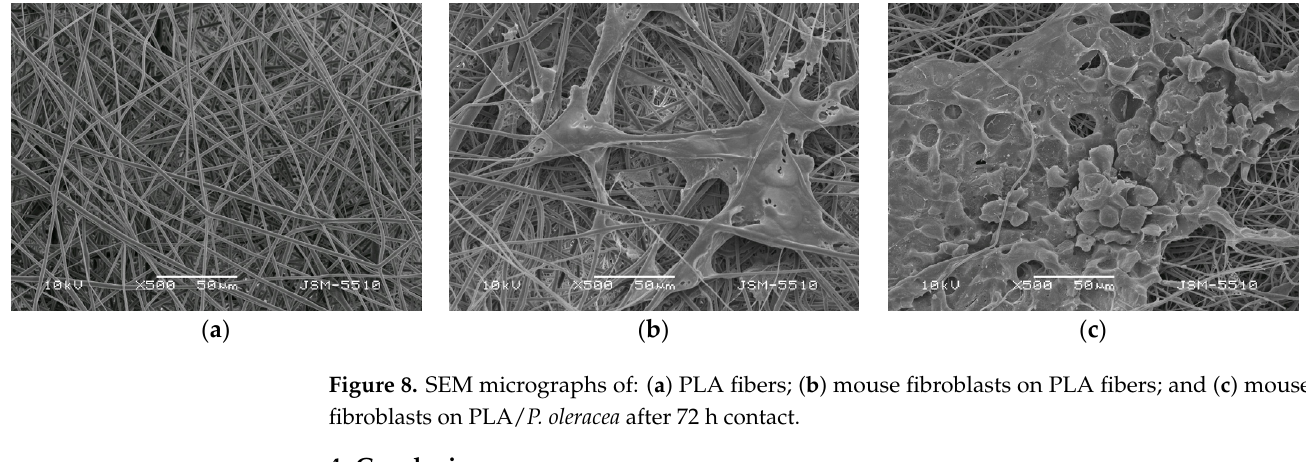
( c ) Figure 7. Fluorescence micrographs of AO and EtBr double-stained mouse BALB/c 3T3 fibroblast cells incubated for 24 h: ( a ) untreated cells; ( b ) PLA mat; and ( c ) PLA/ P. oleracea mat. Live cells are shown in green . Bar: 20 μ m. The mouse BALB/3T3 cell line is suitable for preliminary assessment of cell viability,